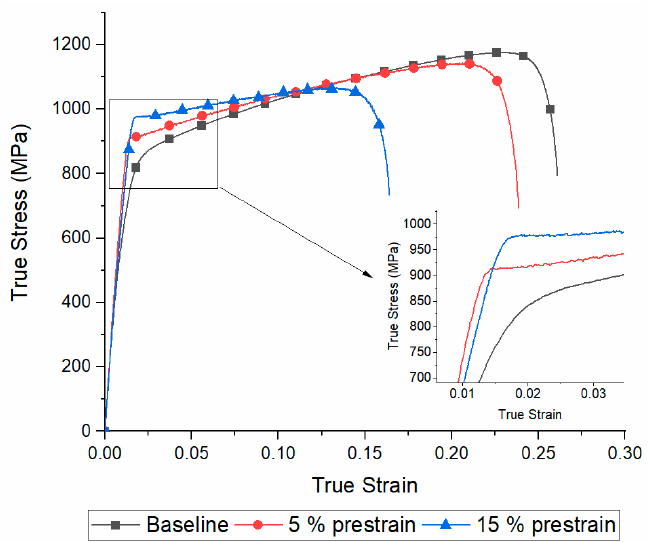
Figure 5. True stress-strain curves of the as received material and the two categories of specimens prestrained at 5% and 15%.